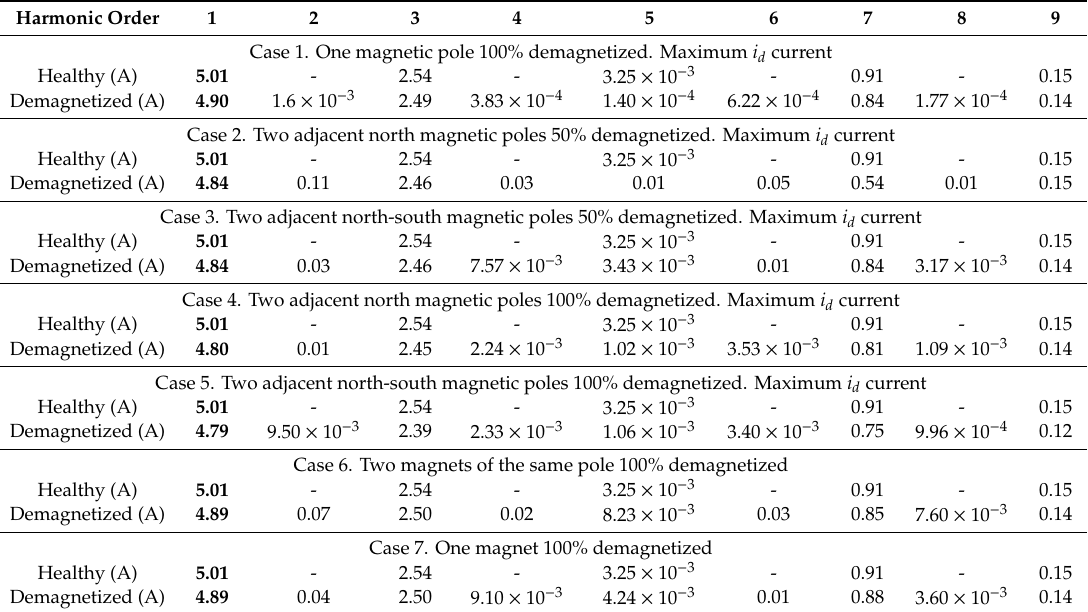
Table 3. Harmonic content of the line currents underrated speed and applying the maximum i d current ( i q = 0). Healthy and partially demagnetized fPMa-SynRMs. Harmonic